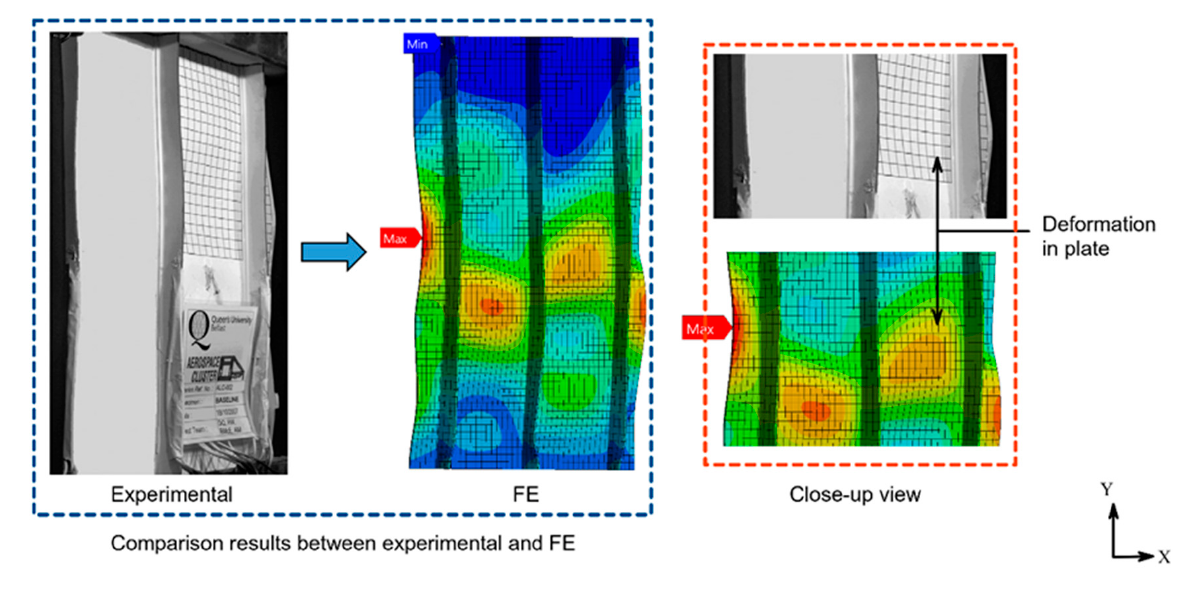
Figure 6. Comparison between experimental [41] and FE on Specimen A.